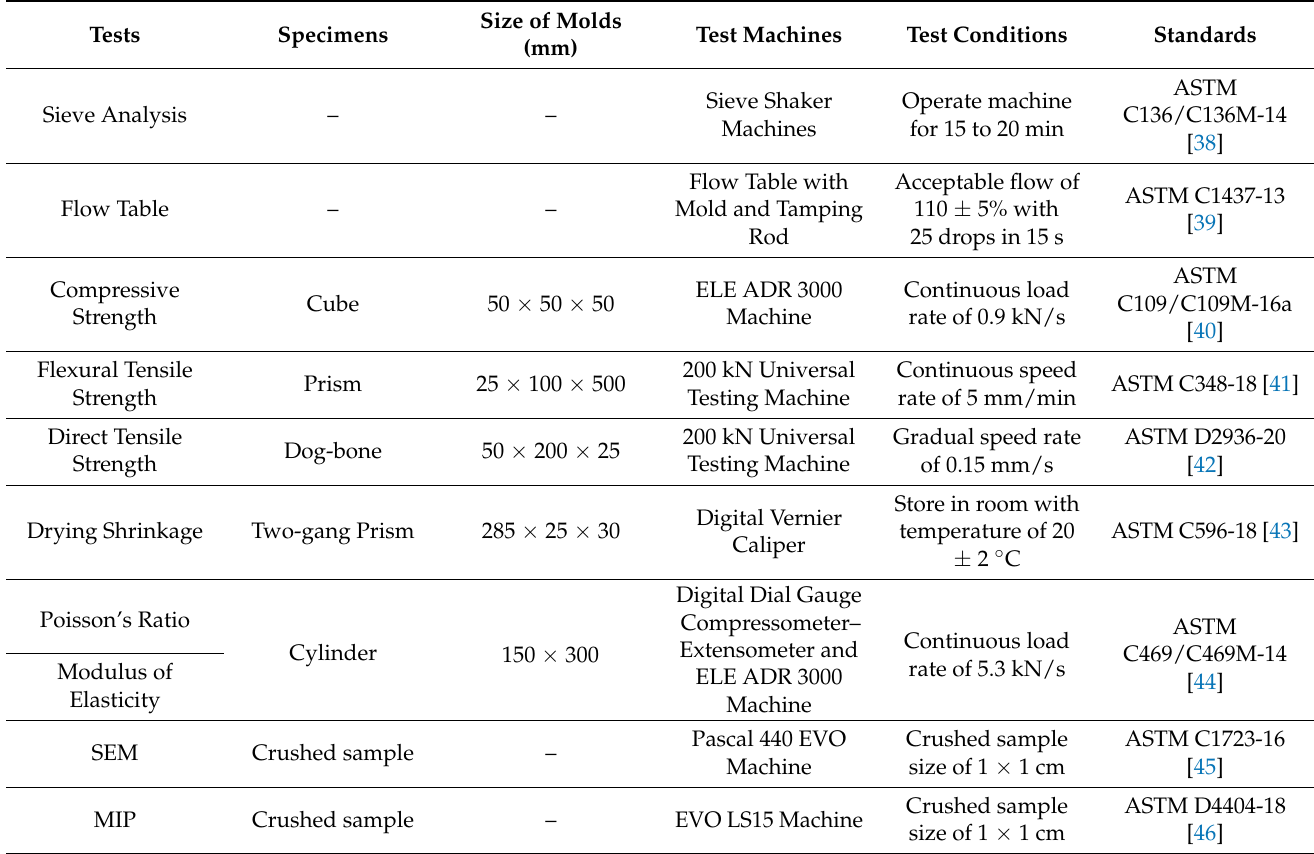
Table 6. Test methods for mortar